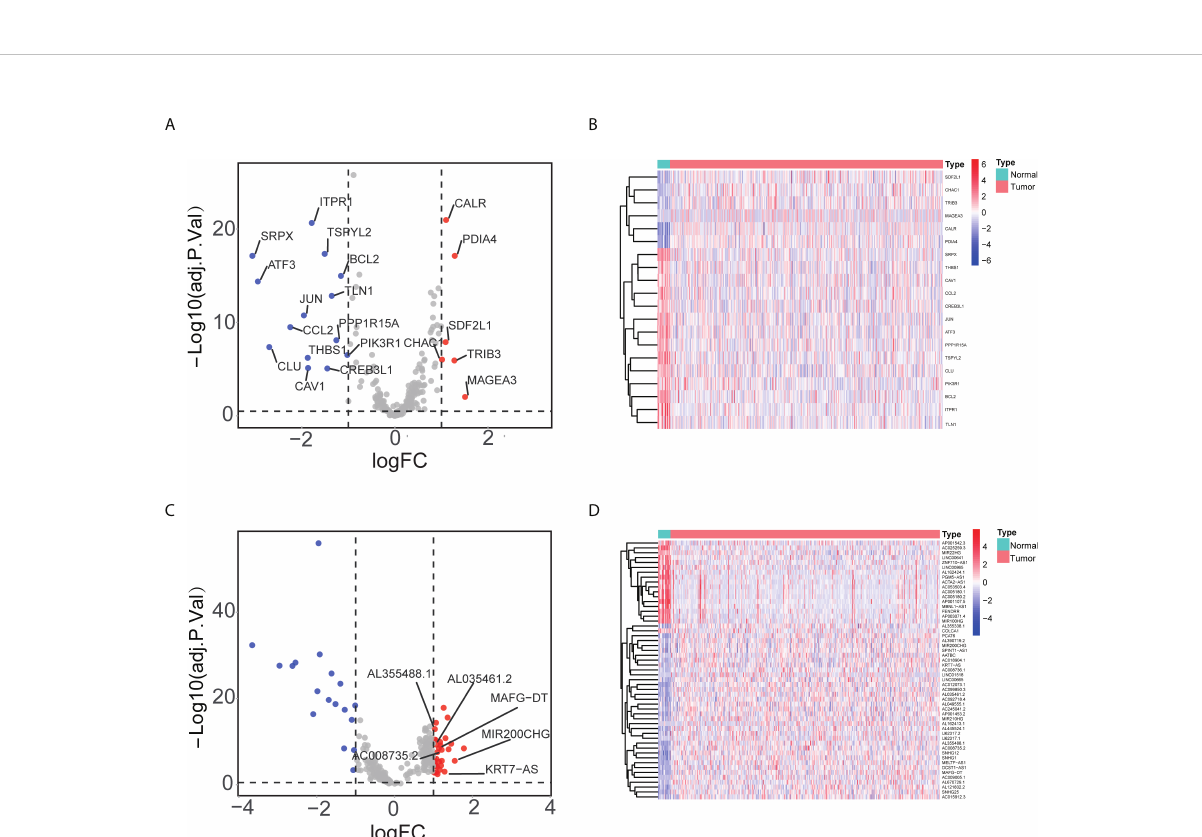
FIGURE 2 Identifying ERS-related lncRNA in tumor. (A) The volcano plot revealed that in tumors, 6 ERS-related genes were up-regulated whereas 14 were down-regulated. (B) The heatmap showed expression pro fi le of ERS-related genes. (C) The volcano plot visualized that in tumors, 35 ERS- related lncRNAs were up-regulated and 18 were down-regulated. (D) The heatmap illustrated expression pro fi le of ERS-related